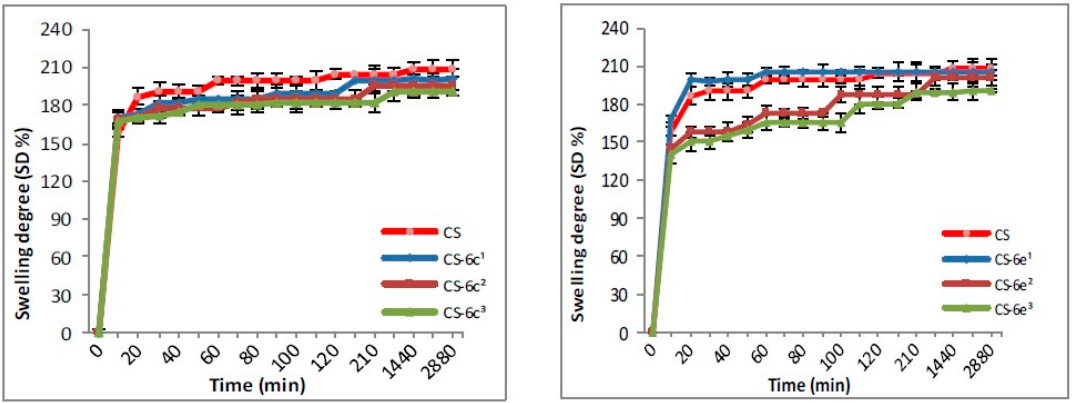
Figure 3. Swelling degree of CS and CS-XTDs (CS-6c; CS-6e) in distilled water at different concentrations ( 1 = 3 mg/mL, 2 = 4 mg/mL, 3 = 5 mg/mL).